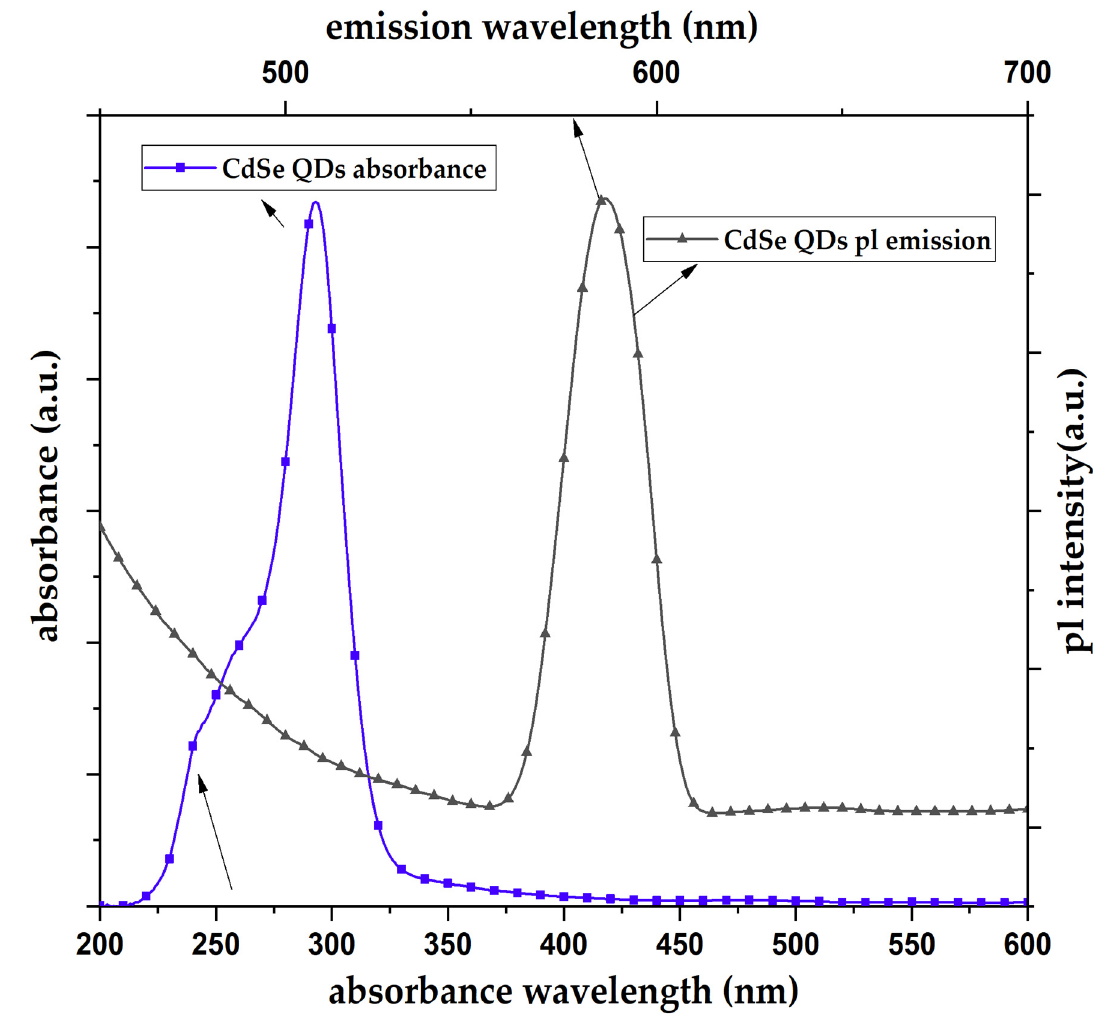
Figure 3. UV – Visible spectroscopy of PVP-stabilized CdSe QDs absorbance at 280 nm and photolu- minescence intensity at 580 nm when excited at 290 nm.